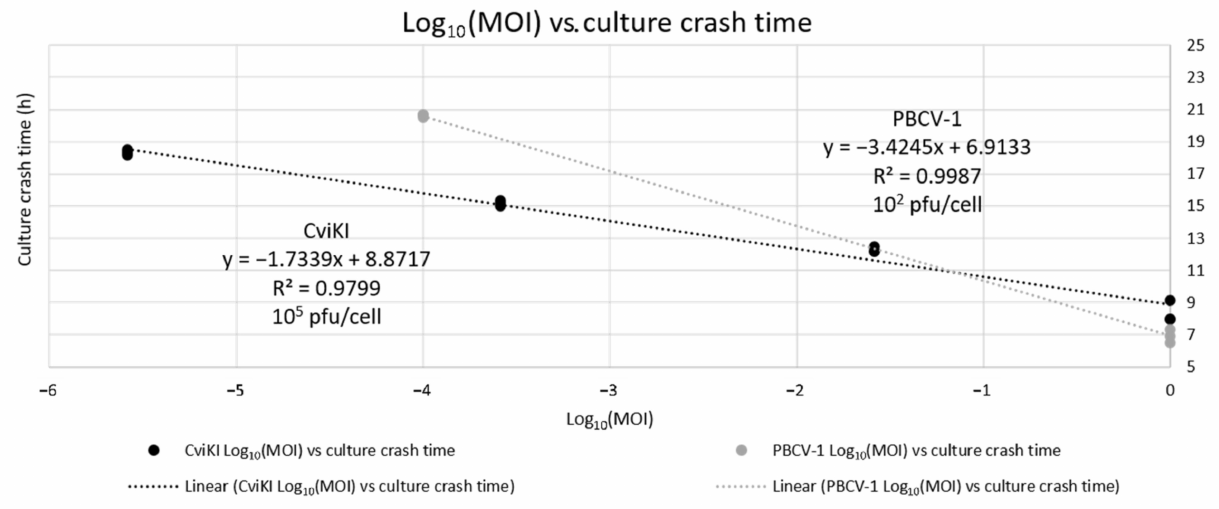
Figure 5. Linear regression of Log 10 of the MOIs versus the culture crash time of infected cells with PBCV-1 and CviKI viruses. The data are reported as three biological replicates for each condition. The linear trendlines were calculated using excel and the R 2 values are